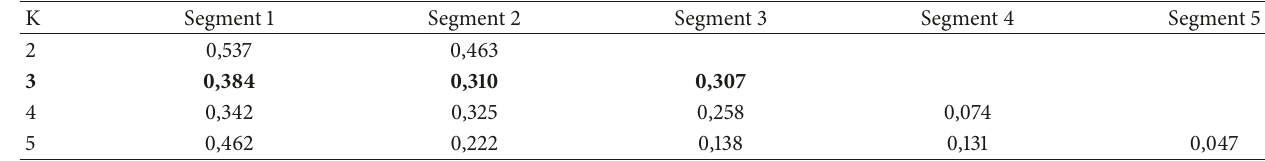
Table 7: Relative segment sizes.